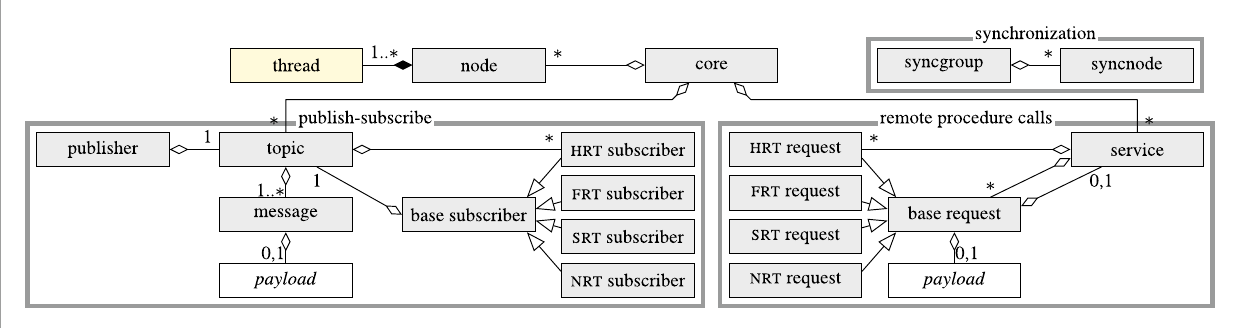
FIGURE 2 µRT architecture overview. While the thread type is defined by the underlying operating system via OSAL and payload are individual types for each topic and request , all other components are specified by µRT.